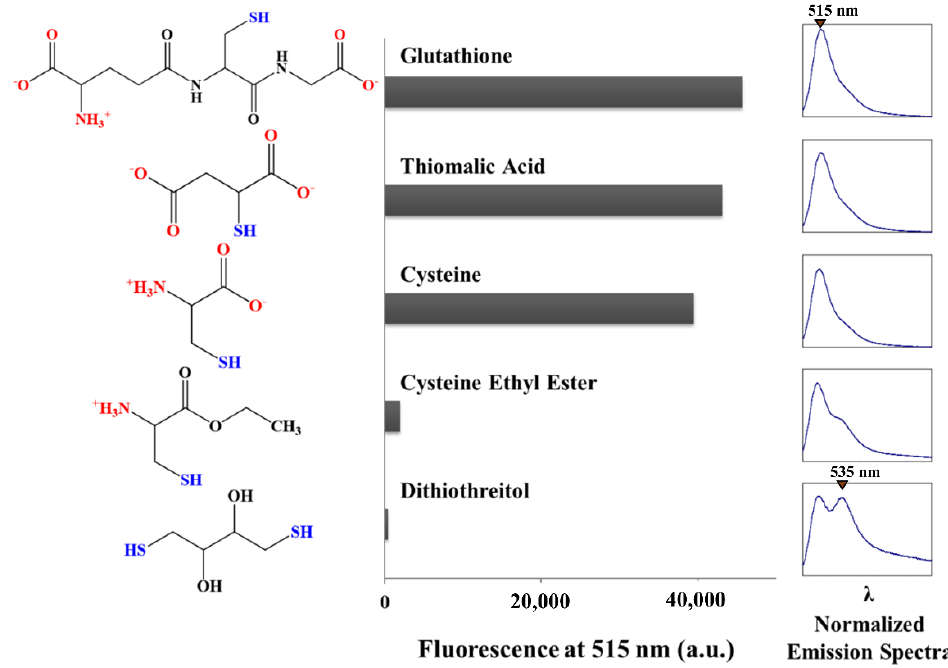
Figure 4. Fluorescence of p-MB after reaction with various thiols. p-MB was allowed to react with select thiol-containing molecules, the structures of which are shown in the left panel. The bar graph in the middle illustrates the fluorescence intensity of each reaction sample at 515 nm after steady state was reached. Normalized emission spectra are shown in the right panel. The emission maximum of the first peak is at ~515 nm, while that of the second peak, if present, is at ~535 nm. Samples were excited at 470 nm. The presence of the conjugates was verified by mass spectrometry (Supplementary Figure S3).